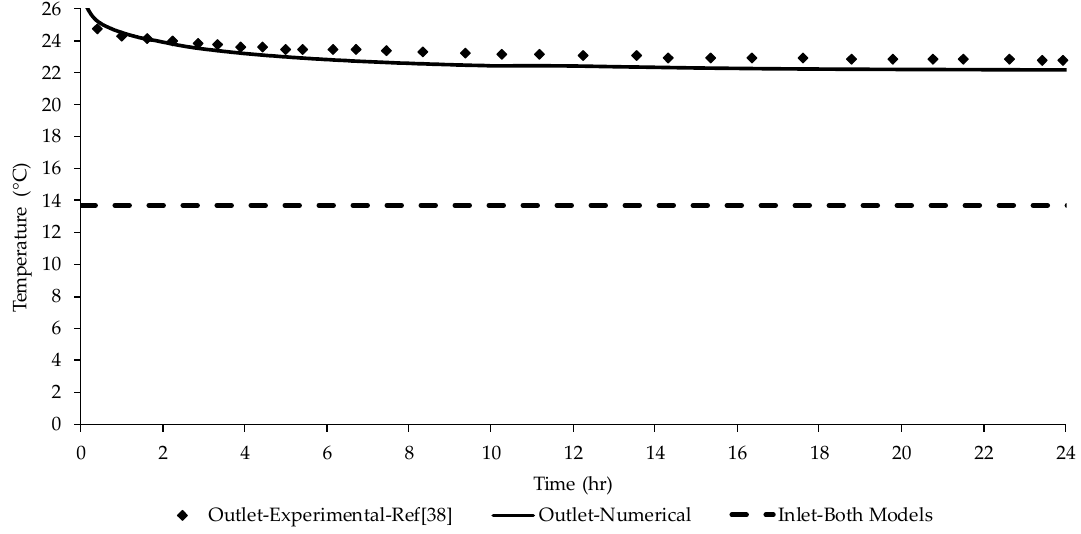
Figure 3. Model validation with experimental thermal storage work in Reference [38].